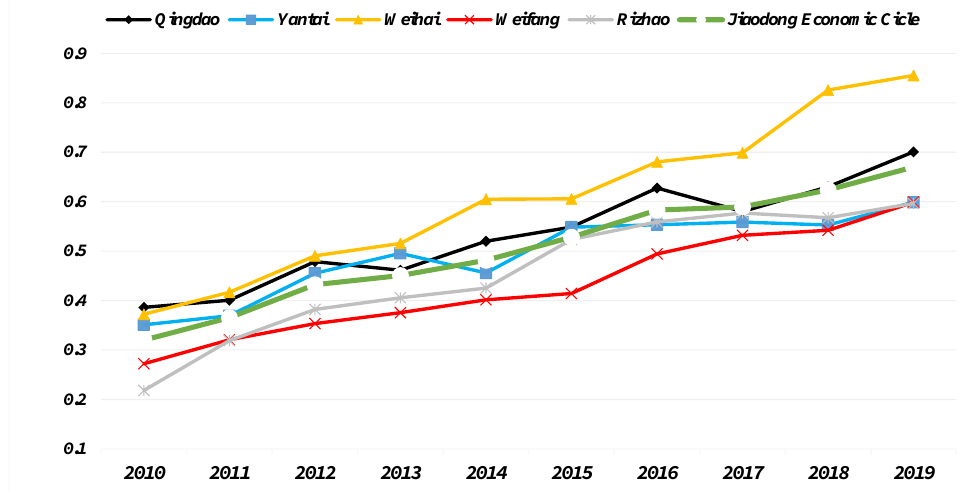
Figure 5. Timeseries of the comprehensive Urban infrastructure level of 5 cities and the entire Jiaodong Economic Circle.